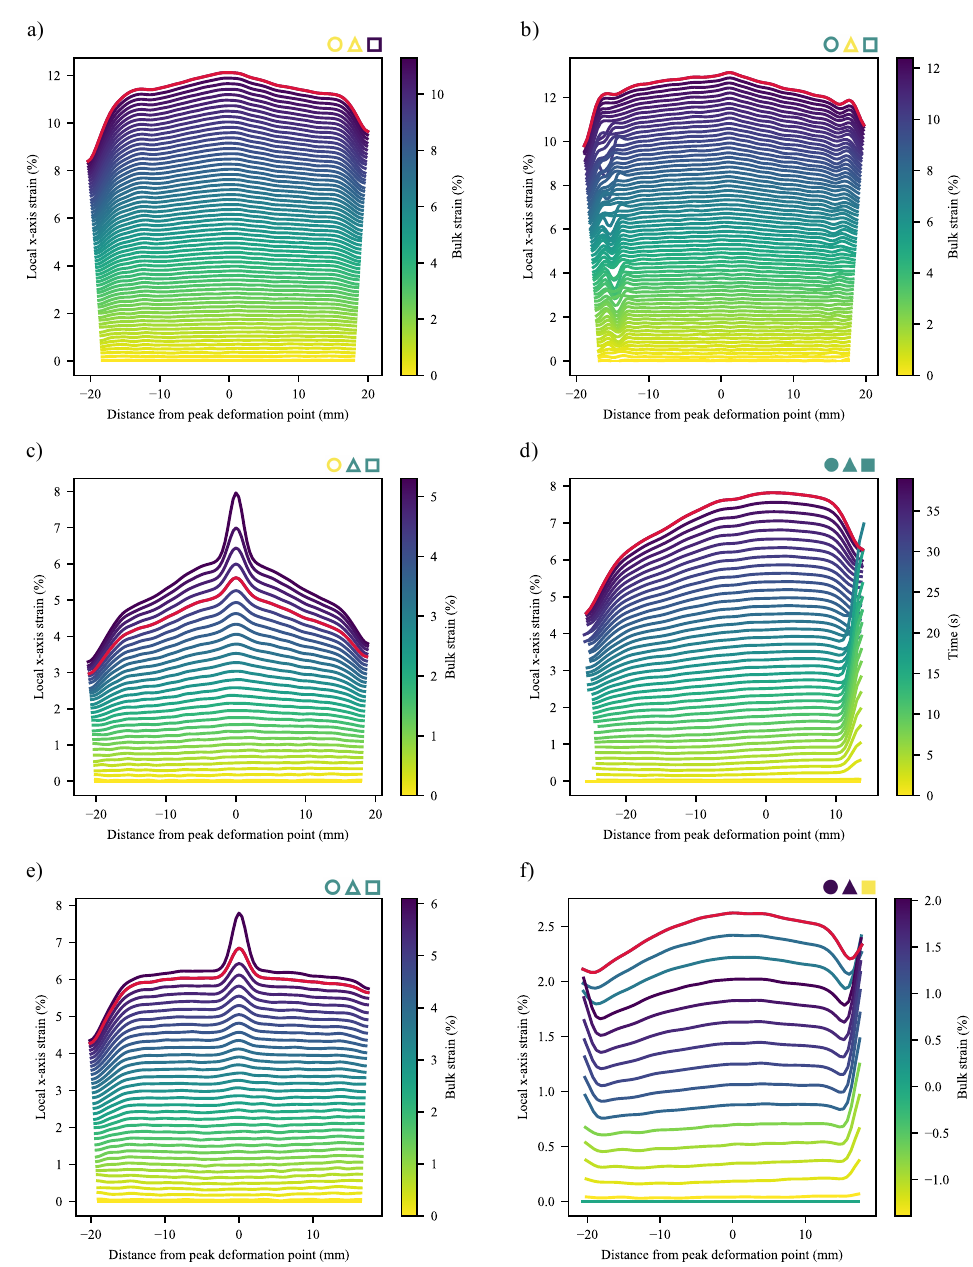
Figure 15. Time-series deformation profiles: yield. ( a ) 0-CB/0-CC/0.5-SP, WL; ( b ) 1.8-CB/0-CC/0.25- SP, WL; ( c ) 0-CB/30-CC/0.25-SP, WL; ( d ) 1.8-CB/30-CC/0.25-SP, REF; ( e ) 1.8-CB/30-CC/0.25-SP, WL; ( f ) 3.6-CB/60-CC/0-SP, REF. For the sake of brevity, complete profiles are shown in suitable cases. The yield profiles are highlighted in